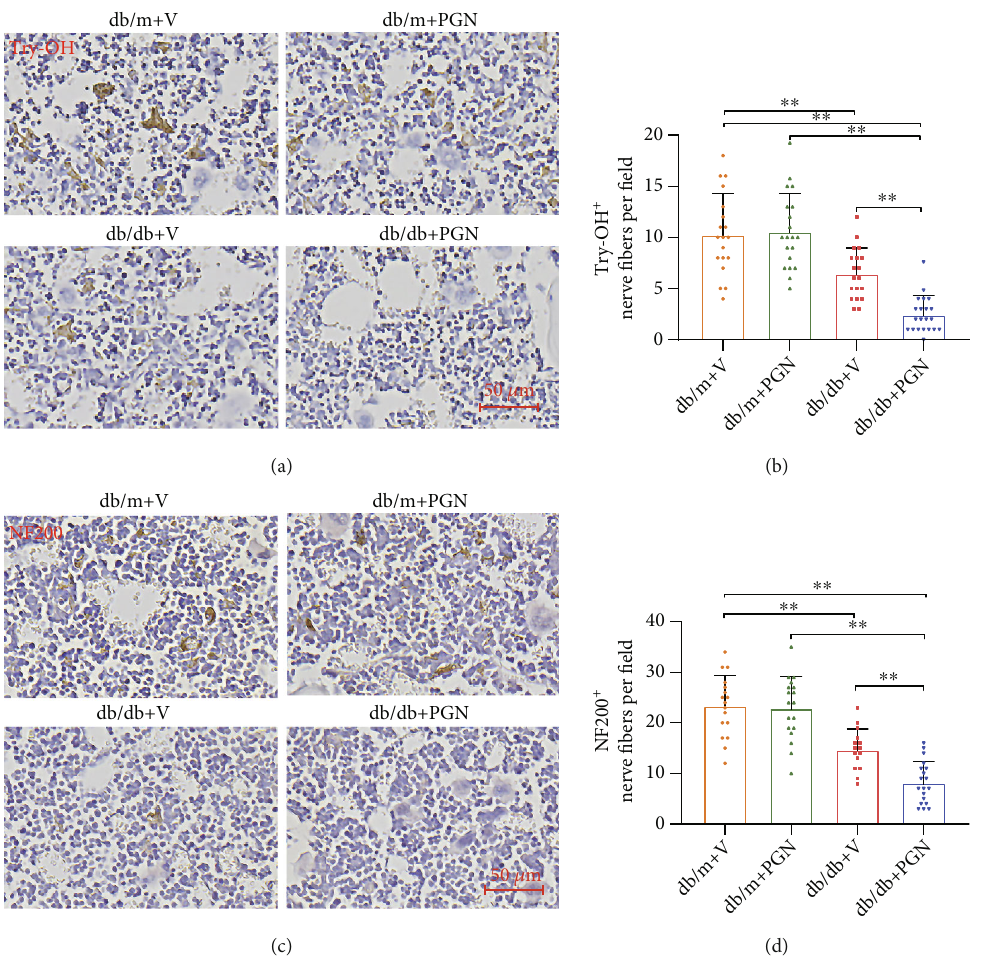
Figure 4: PGN administration dramatically decreased bone marrow innervation in diabetic db/db mice. (a) Representative images of immunohistochemical staining for tyrosine hydroxylase in femur cross-sections from mice in each group. (b) The number of Try-OH + nerves was dramatically reduced in the bone marrow of db/db mice treated with PGN compared that in the bone marrow of mice treated with the vehicle control ( n = 19 − 21 per group). (c) Representative images of immunohistochemical staining for NF200 in mouse femurs. (d) PGN further decreased the number of NF200 + nerve fi bers in db/db mice ( n = 15 − 19 per group). Data represent mean ± SD . PGN: peptidoglycan; V: vehicle; Try-OH: tyrosine hydroxylase; NF200: neuro fi lament 200. ∗ P < 0 : 05 , ∗∗ P < 0 : 01